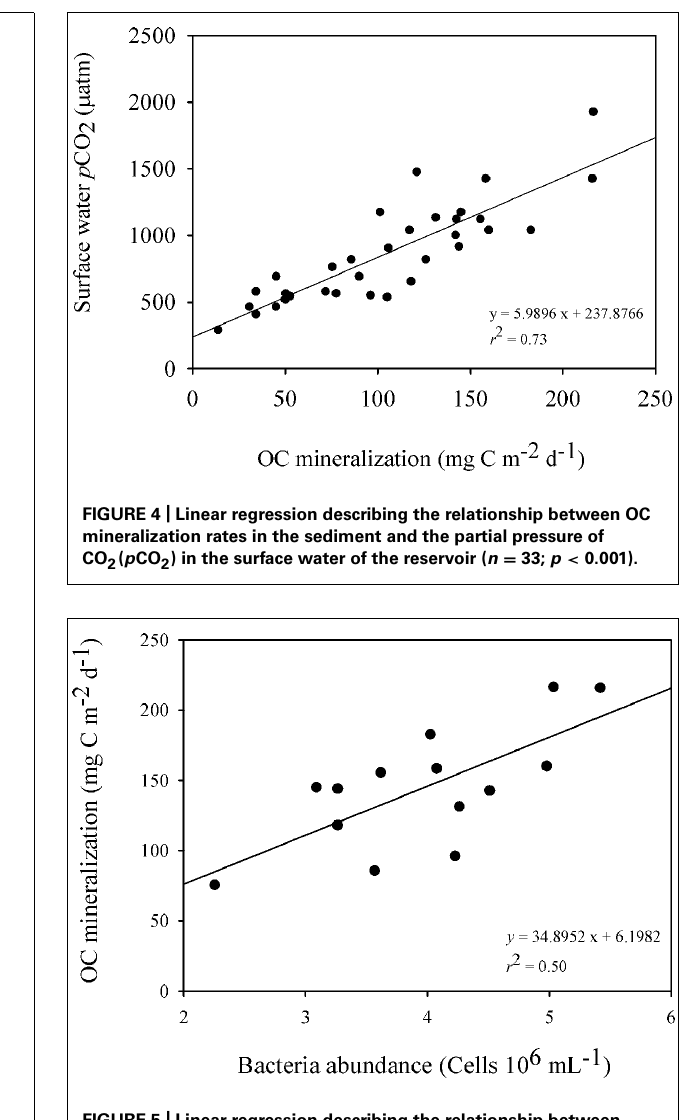
FIGURE 5 | Linear regression describing the relationship between bacteria abundance and OC mineralization rates from the overlying water of the incubation cores over time ( n = 18; p <